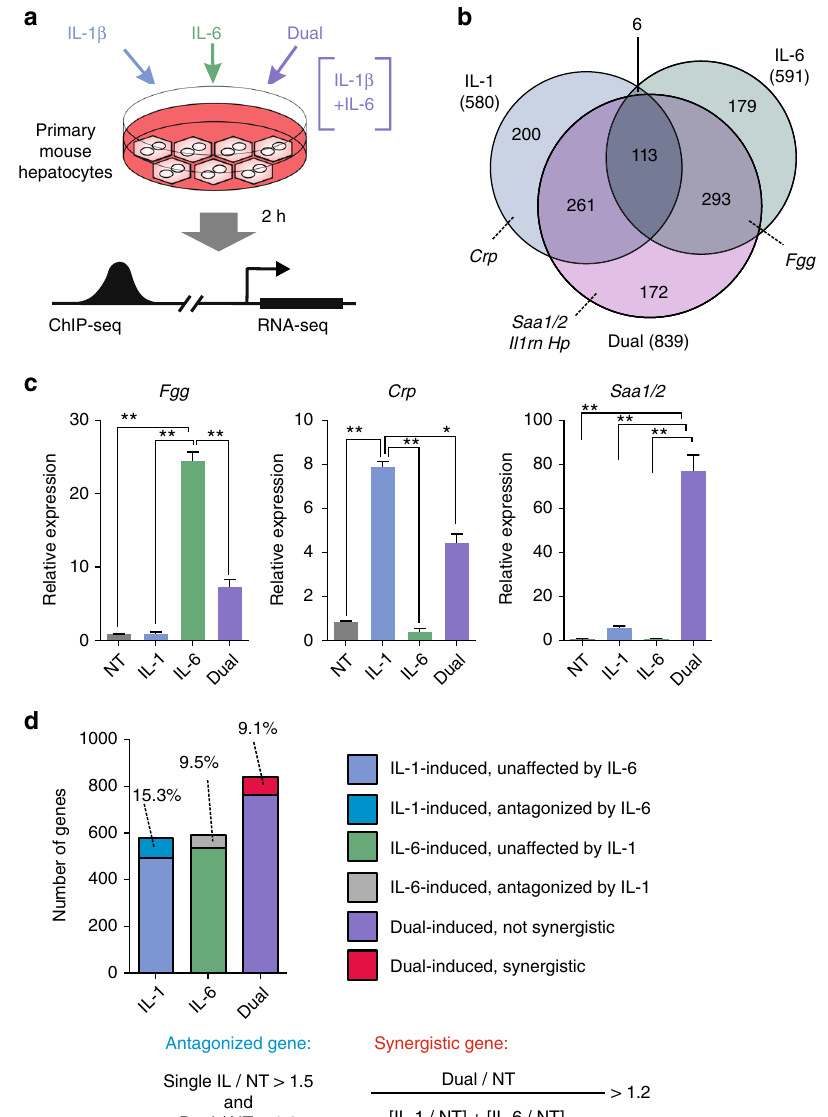
Fig. 1 A multifaceted response of primary hepatocytes to pro-in fl ammatory cytokines IL-1 β and IL-6. a Experimental setup used throughout the study. Primary mouse hepatocytes were treated with IL-1 β , IL-6 or both for 2 h (cytokine conc. 10 ng ml − 1 ). Then, cells were collected for downstream experiments. b Venn diagram portraying cytokine-induced genes and their different response under the various treatments. In parentheses is the total number of genes induced under each condition (1.5-fold change, adjusted p -value ≤ 0.05, measured with CuffDiff). Prominent APR genes are highlighted. For more details and for repressed genes, see Supplementary Data 1. c RNA levels of cytokine-induced genes in primary hepatocytes following a 2 h cytokine treatment. Both antagonistic and synergistic relationships between IL-1 β and IL-6 are shown. To more reliably measure changes stemming from transcriptional regulation and not RNA stability, nascent transcripts, rather than mature ones, were measured by quantitative PCR (qPCR) throughout the study. To achieve this, the ampli fi ed gene region spans exon-intron junctions in all examined genes. All qPCR gene measurements in the study are relative (the NT sample in each experiment was set with the value 1) and were normalized with the housekeeping gene Tbp . Representative experiment shown of at least three independent repeats. Error bars represent s.d. of three technical replicates. Asterisks denote statistical signi fi cance as determined by an unpaired, two-tailed t-test. Single asterisk denotes p value ≤ 0.05, double asterisks denote p -value ≤ 0.01. d The fraction of antagonistically-regulated and synergistically induced genes in each treatment group is presented. Cutoff criteria for antagonism and synergism are